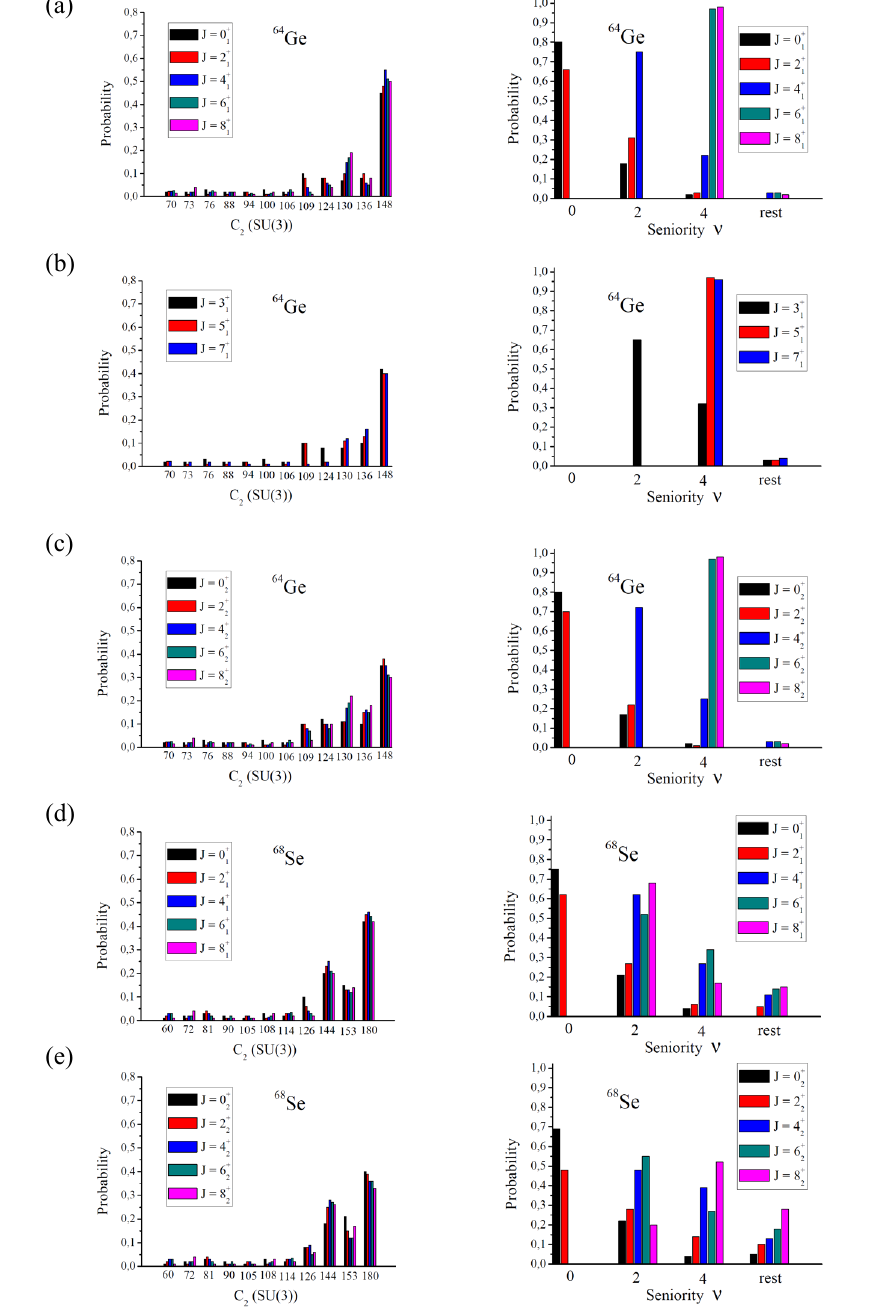
Figure 3. (Color online) Evaluation of the goodness of the pseudo- SU (3) and O (6) symmetries in the positive-parity energy eigenstates from (a) the g.s. band and (b) and (c) the excited band of 64 Ge. The same is given for 68 Se in parts (d) and (e) of the